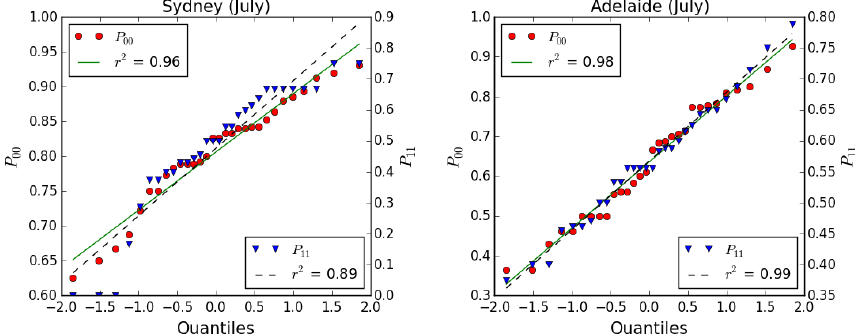
Figure 6. Normal probability plots of P 00 and P 11 for July (typical of other